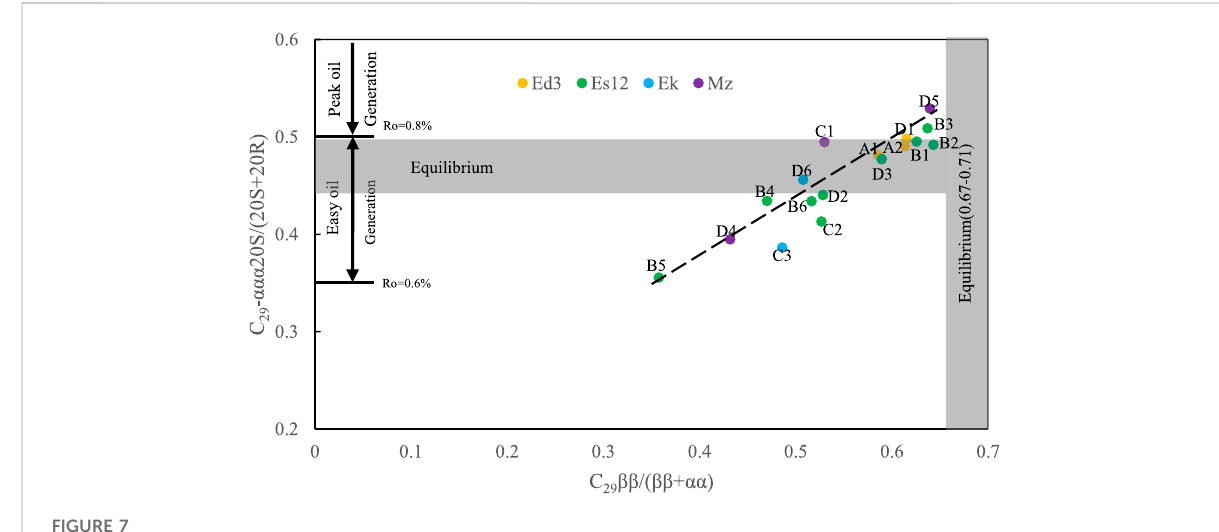
FIGURE 7 Correlation between C 29 - ααα 20S/(20S+20R) and C 29 ββ /( ββ + αα ) sterane of crude oil in Qinnan